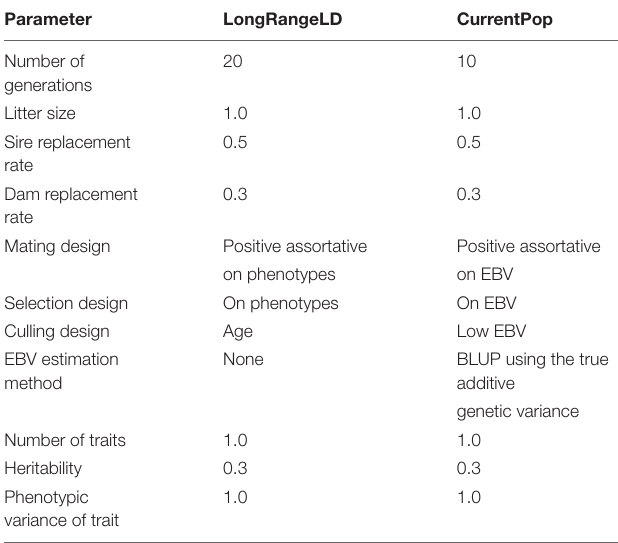
TABLE 1 | Parameters used for the simulation of the populations LongRangeLD and